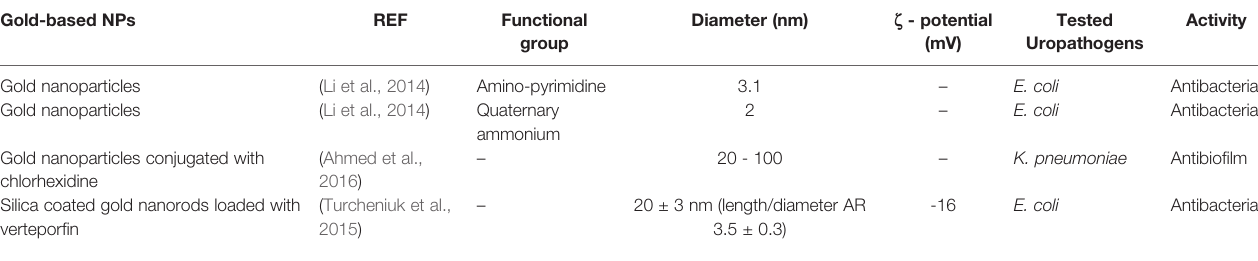
TABLE 8 | Physicochemical characteristics of gold-based NPs. Gold-based